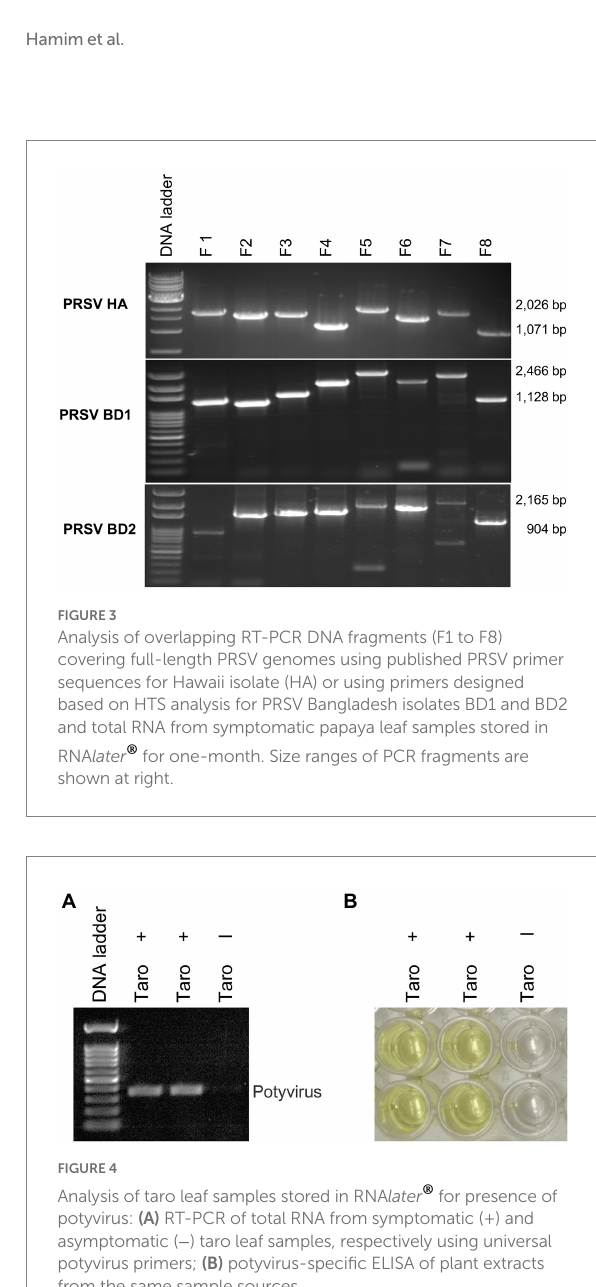
Analysis of taro leaf samples stored in RNA later ® for presence of potyvirus: (A) RT-PCR of total RNA from symptomatic (+) and asymptomatic ( − ) taro leaf samples, respectively using universal potyvirus primers; (B) potyvirus-specific ELISA of plant extracts from the same sample sources.